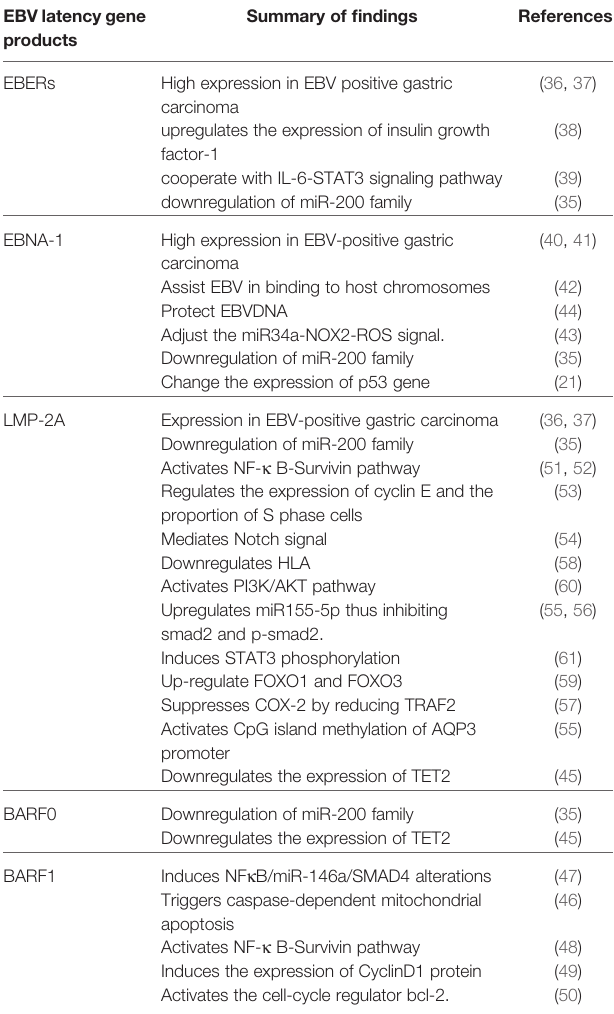
TABLE 1 | Summary of EBV proteins expressed during latency